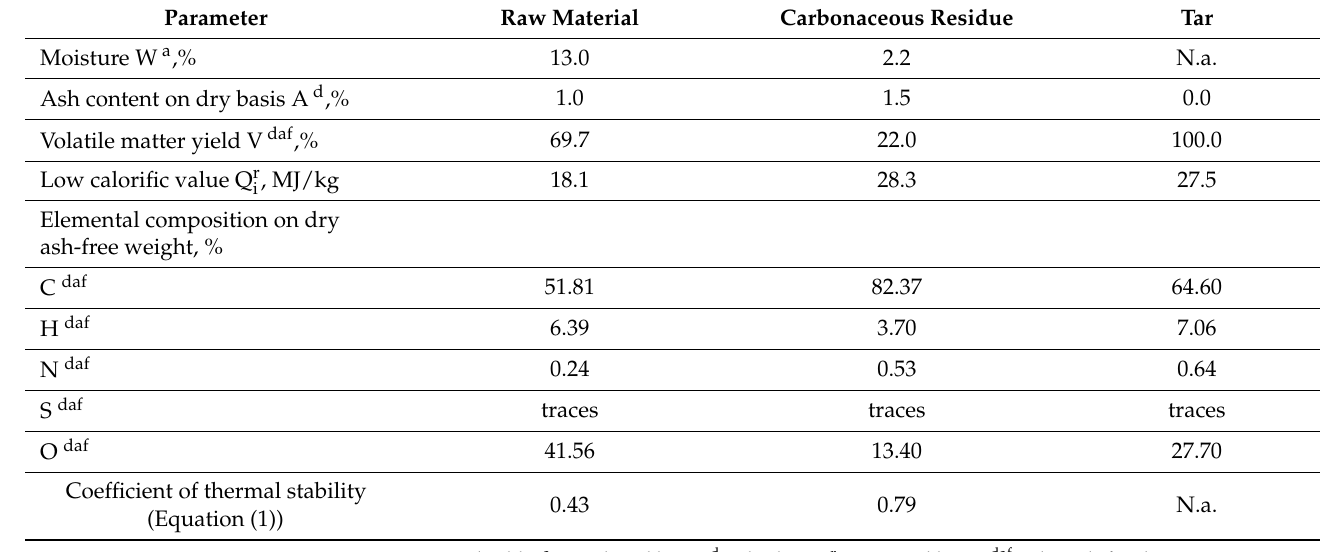
Table 1. Proximate and ultimate analysis of Siberian pine nutshell and products of